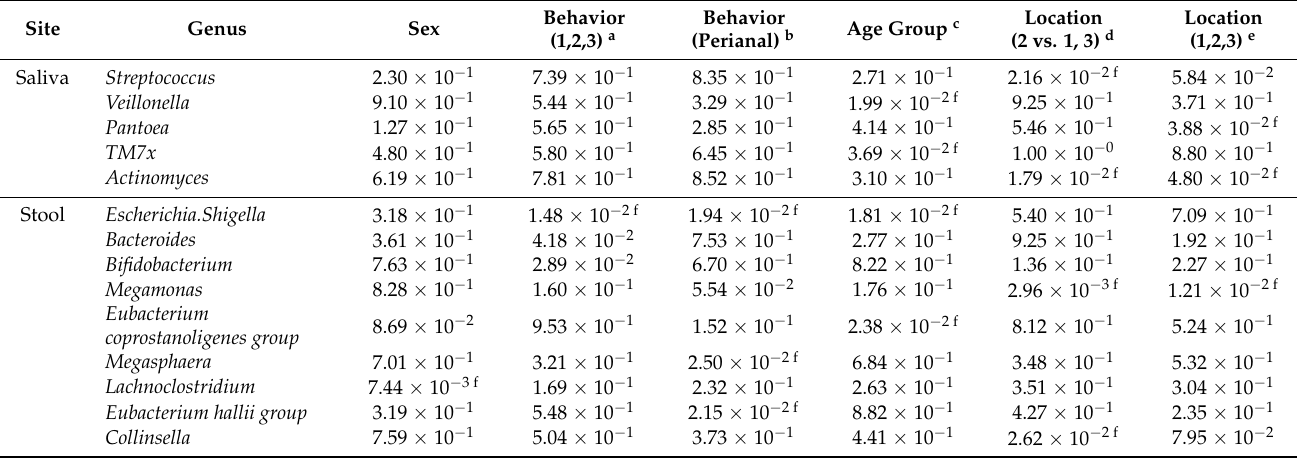
Table 4. p -values of Kruskal–Wallis test by sample groups among clinical subgroups (continued to next